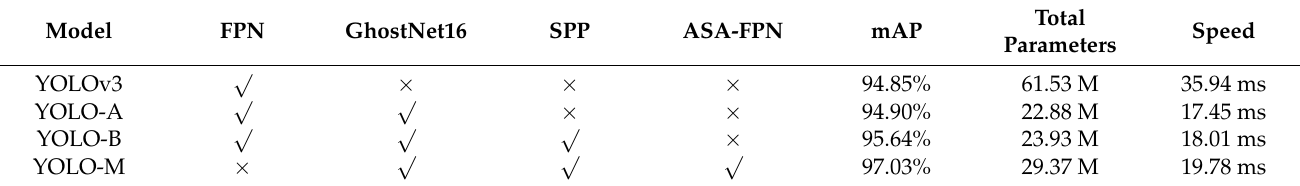
Table 4. Test results obtained for the four algorithms on the test set (IoU threshold set to 0.5). Model